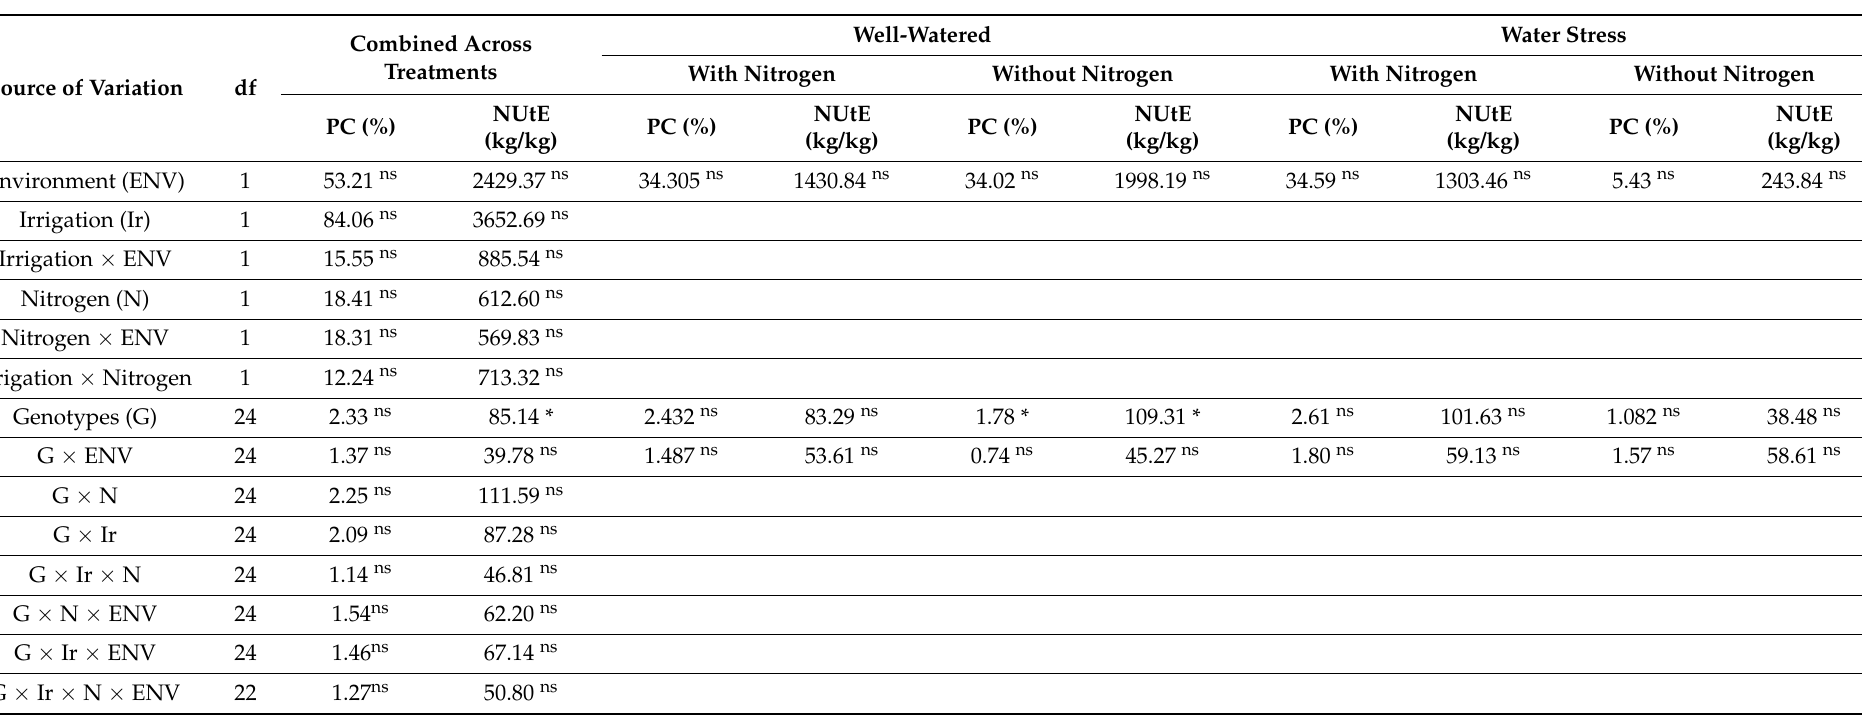
Table 4. Analysis of variance combined across environment of grain protein content (PC) and nutrient utilization efficiency (NUtE) analyzed in the diallel systems with six Algerian maize populations evaluated along with four checks in two environments in Algiers under both managed drought and nitrogen